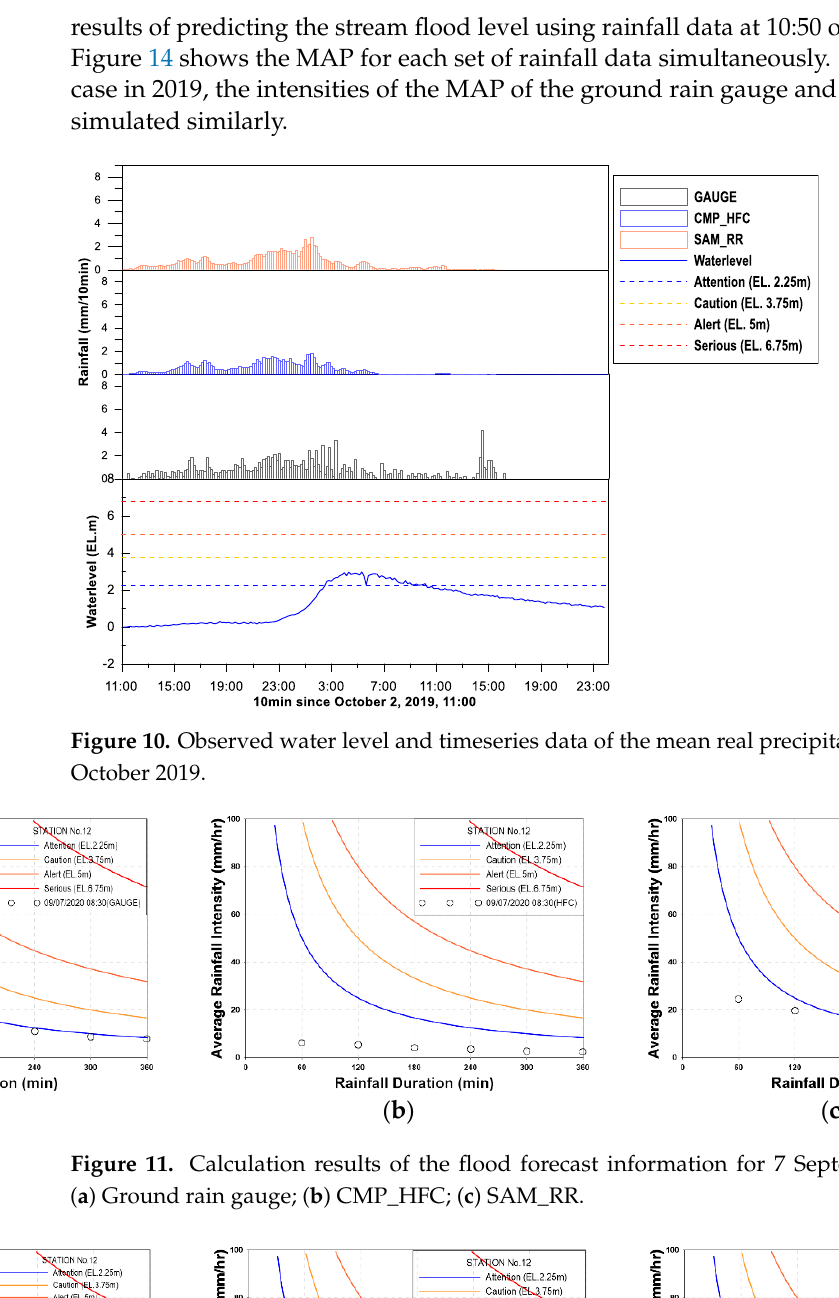
Figure 11. Calculation results of the flood forecast information for 7 September 2020, at 08:30: ( a ) Ground rain gauge; ( b ) CMP_HFC; ( c ) SAM_RR.